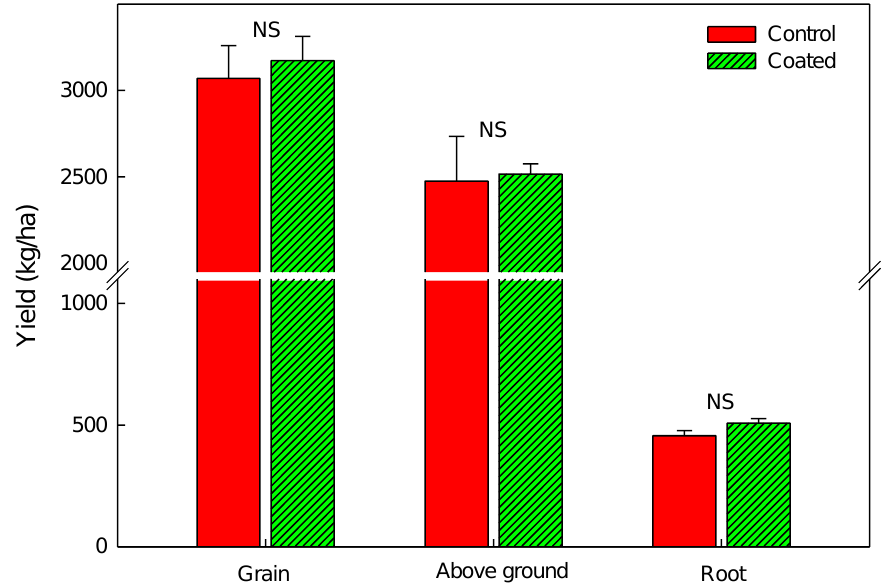
Figure 1. Changes of yields (grain, above ground, and root) resulting from different seed coating methods. NS means not significantly differing between seed coating methods ( p > 0.05).